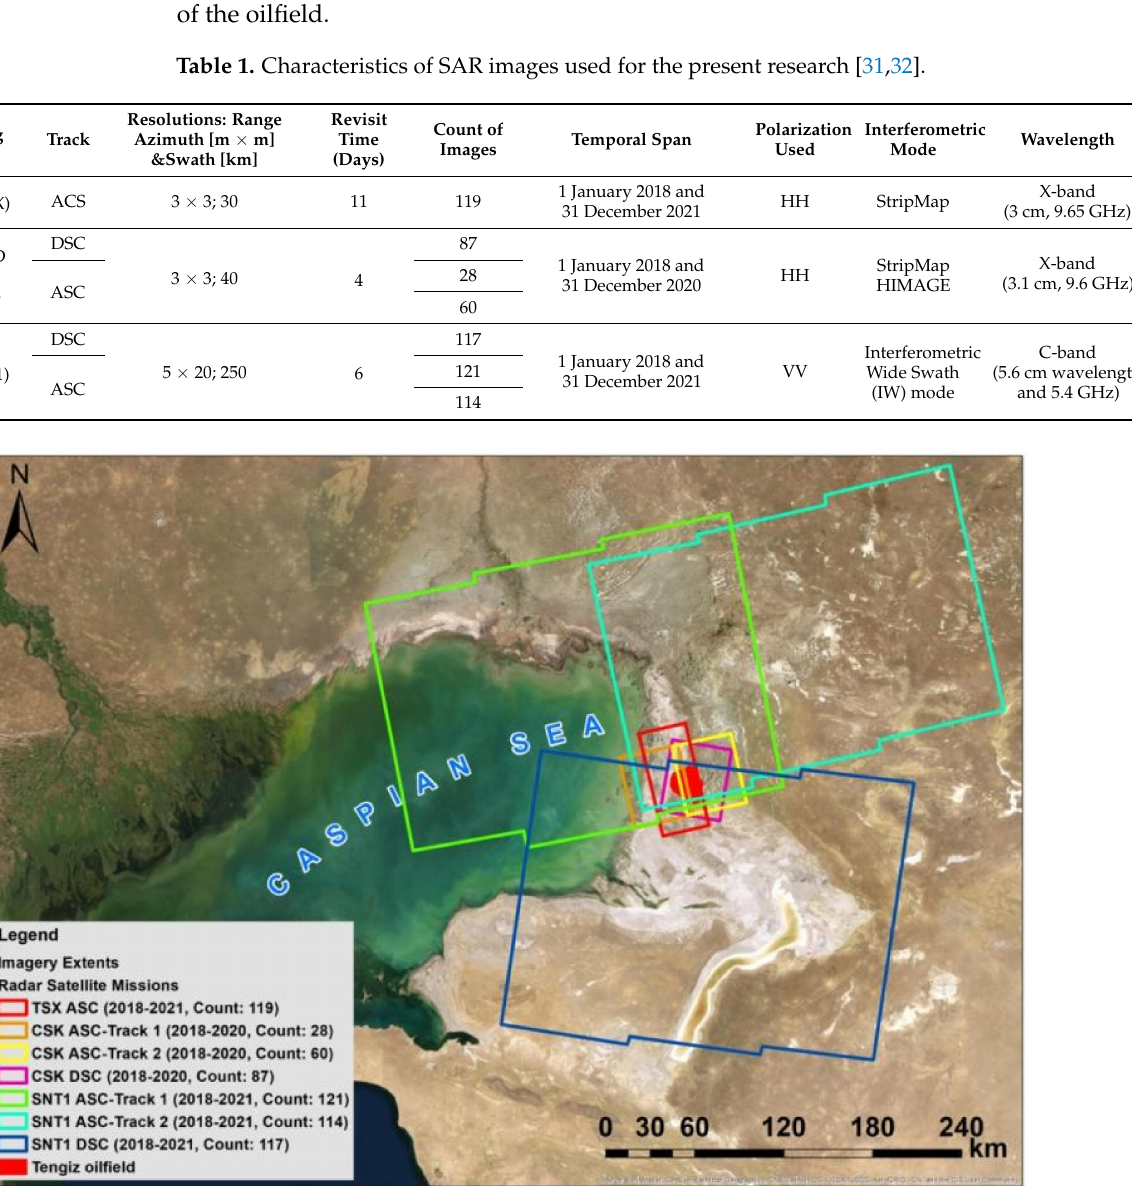
Figure 2. Extents, count and acquisition period of TSX, CSK and SNT1